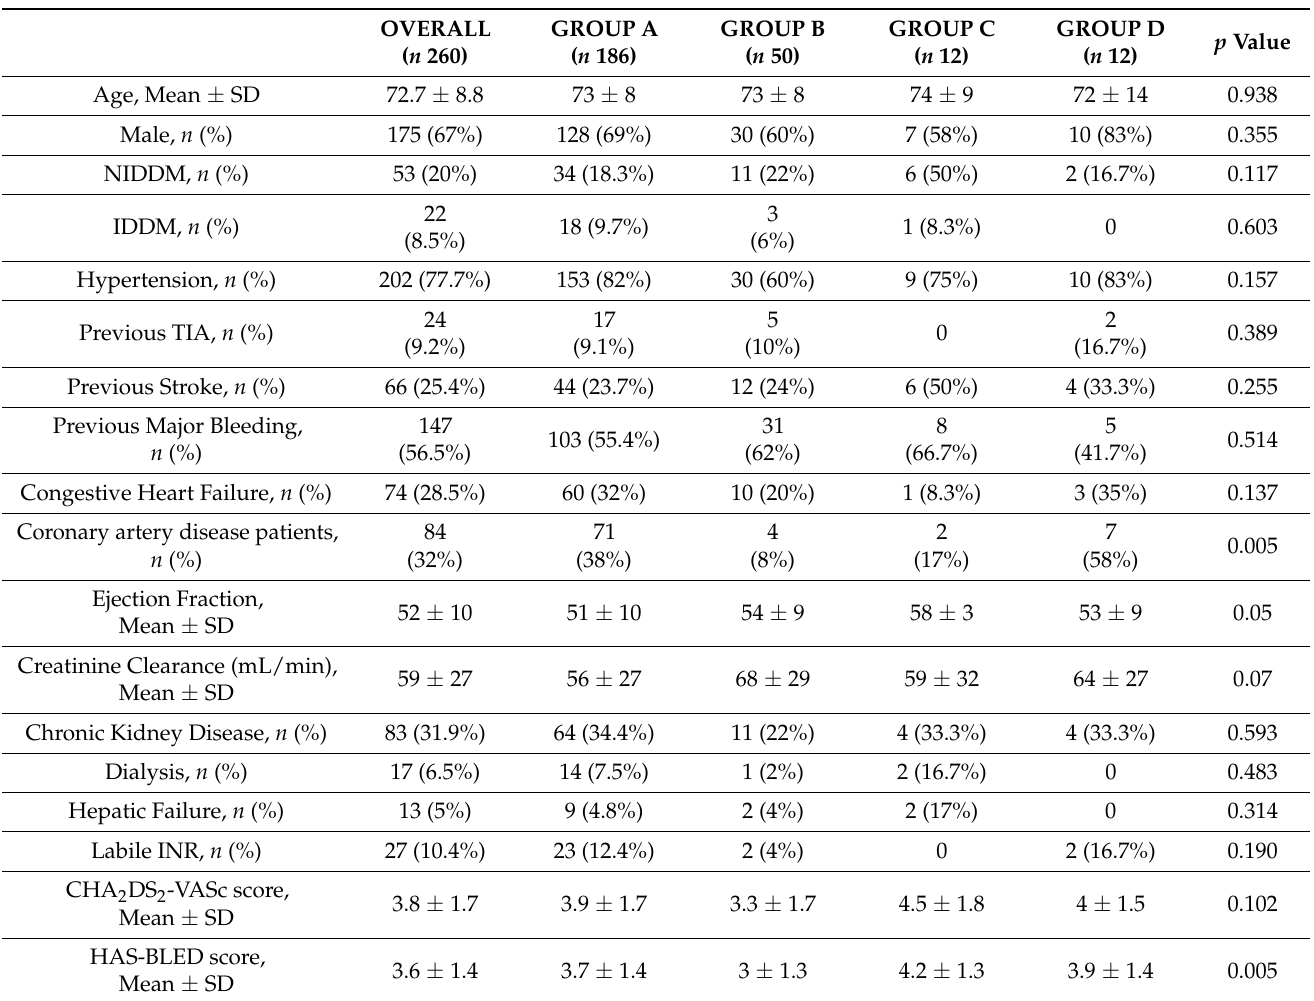
Table 1. Baseline characteristics. NIDDM: non-insulin dependent diabetes mellitus; IDDM: insulin dependent diabetes mellitus; TIA: transient ischemic attack; INR: international normalized ratio. GROUP A dual antiplatelet therapy; GROUP B anticoagulant therapy; GROUP C single antiplatelet therapy or no therapy; GROUP D combination of antiplatelet and anticoagulant